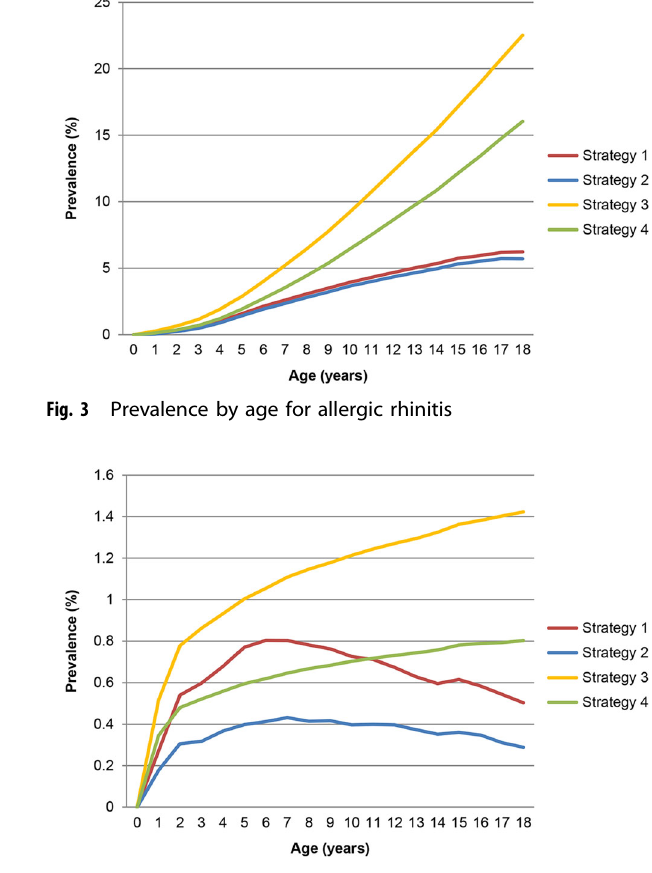
Fig. 4 Prevalence by age for atopic